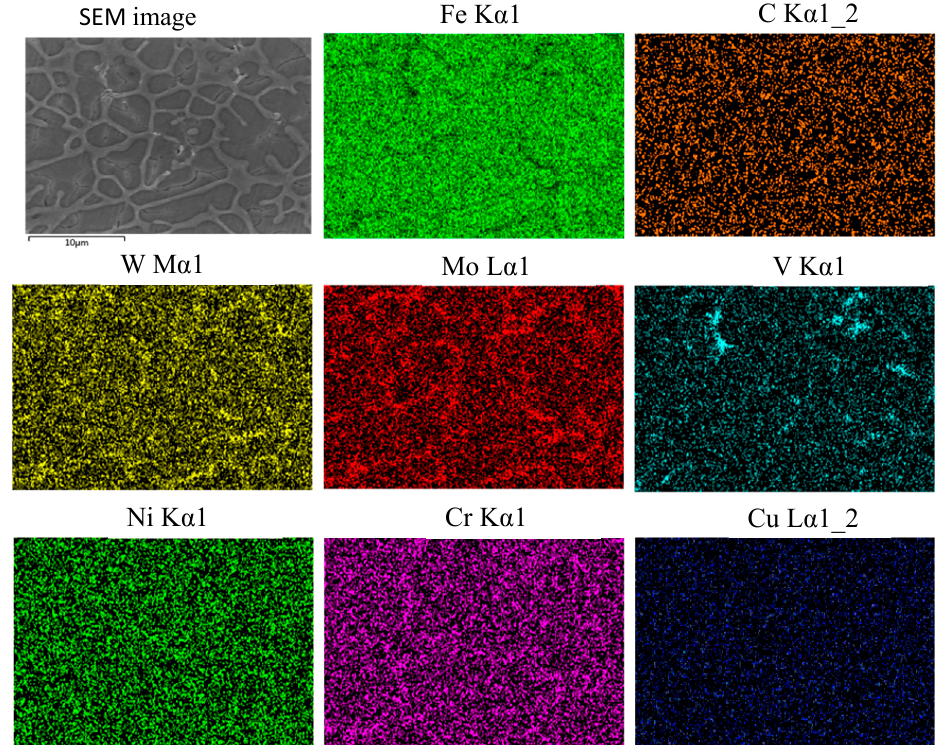
Figure 7. The morphology of equiaxed grain and its element distribution.